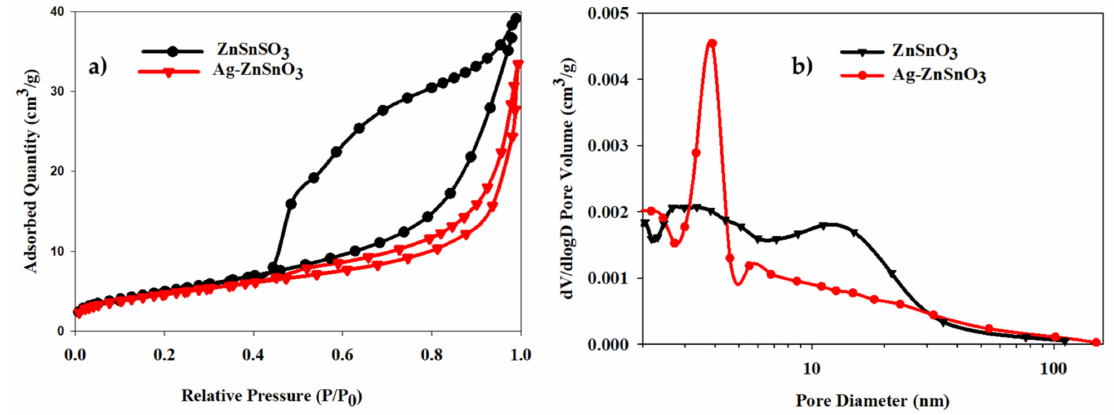
Figure 2. ( a ) N 2 adsorption-desorption isotherm curve, and ( b ) BJH pore size distribution (PSD) of synthesized sample